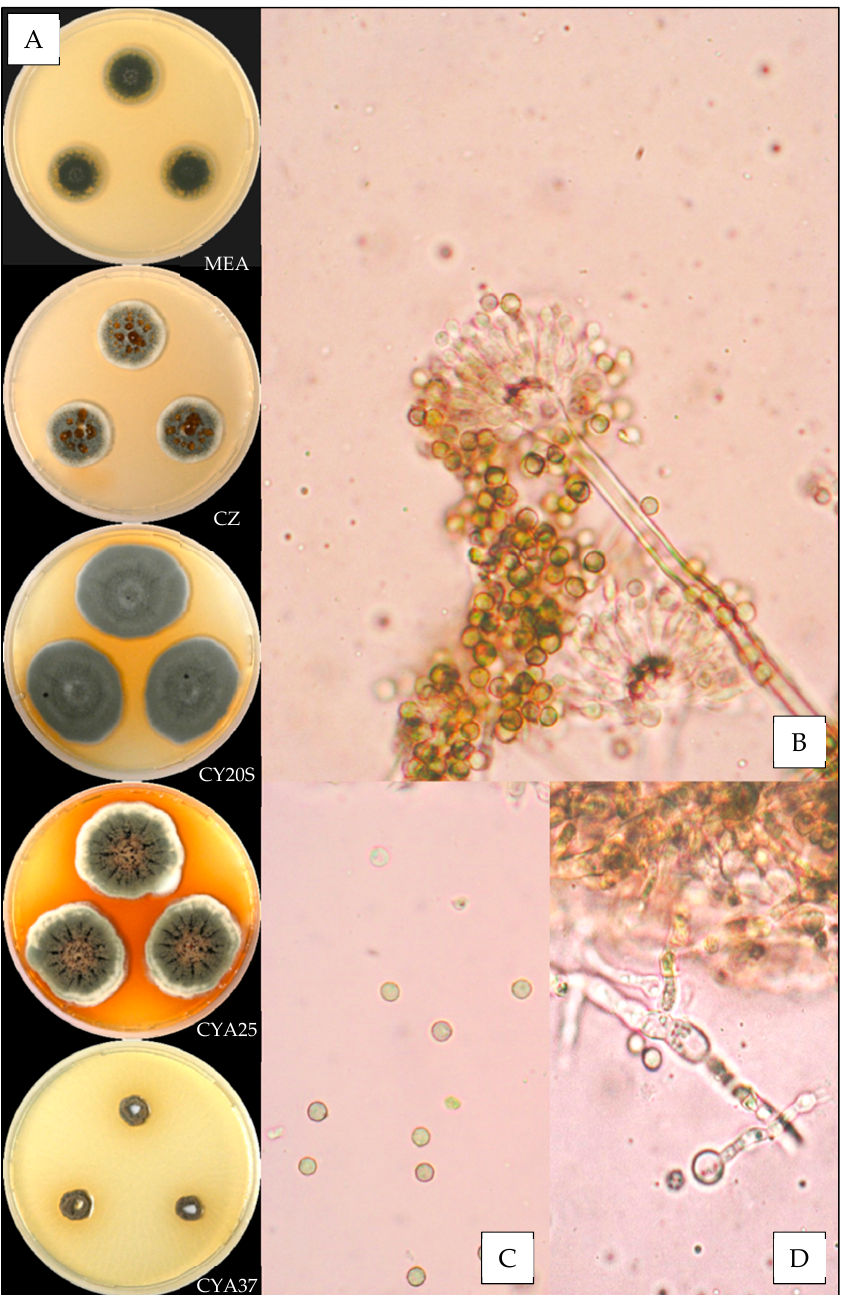
Figure 8. Aspergillus sydowii : ( A ) from top to bottom, colonies on MEA, CZ, CY20S, CYA25 and CYA37, 14 days. ( B ) Conidial head, ( C ) conidia and ( D ) chlamydospores (1000×).